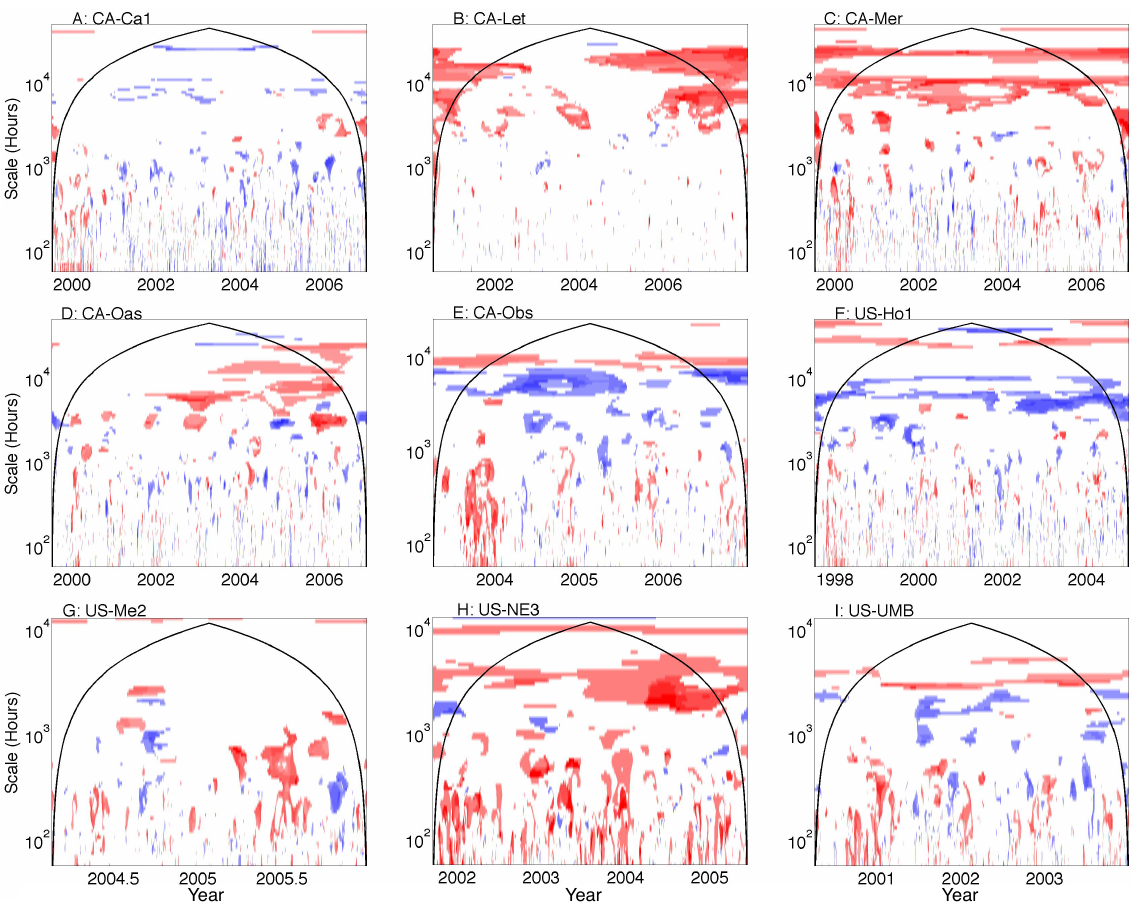
Fig. 6. The ratio of wavelet coherence significance tests for models with prognostic prescribed phenology for nine sites in the North American Carbon Program Interim Synthesis. The color bar follows Fig. 5. Areas of dark blue represent times and scales for which models that use prognostic leaf area index (LAI) are significantly related to NEE measurements and those that use prescribed LAI are not significantly related to NEE measurements. Regions for which models that use prescribed LAI are significant and those that use prognostic LAI are not significant are shown as dark red. The color bar follows Fig.